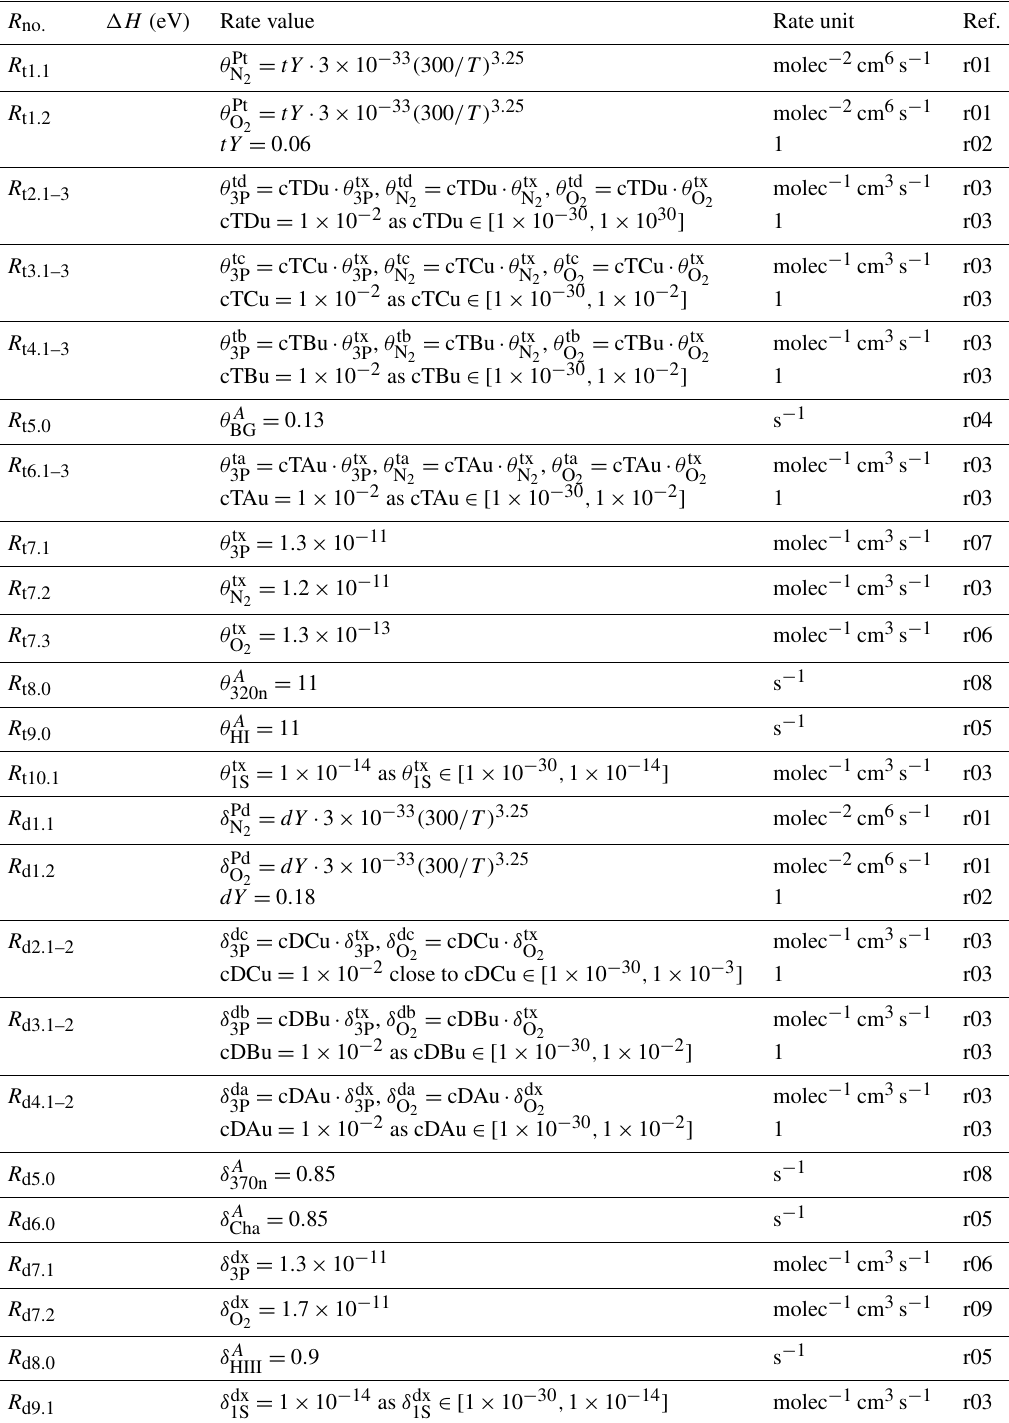
Table 8. Rate values of the processes considered in the MAC model involving O 2 (A) and O 2 (A (cid:48) ) and listed in Table 5. References: r01 – Smith and Robertson (2008), r02 – Bates (1988a), r03 – Lednyts’kyy and von Savigny (2016), r04 – Rodrigo et al. (1988), r05 – Bates (1988b), r06 – Krasnopolsky (2011), r07 – Kenner and Ogryzlo (1984), r08 – Stegman and Murtagh (1991), r09 – López-González et al. (1992a). R no